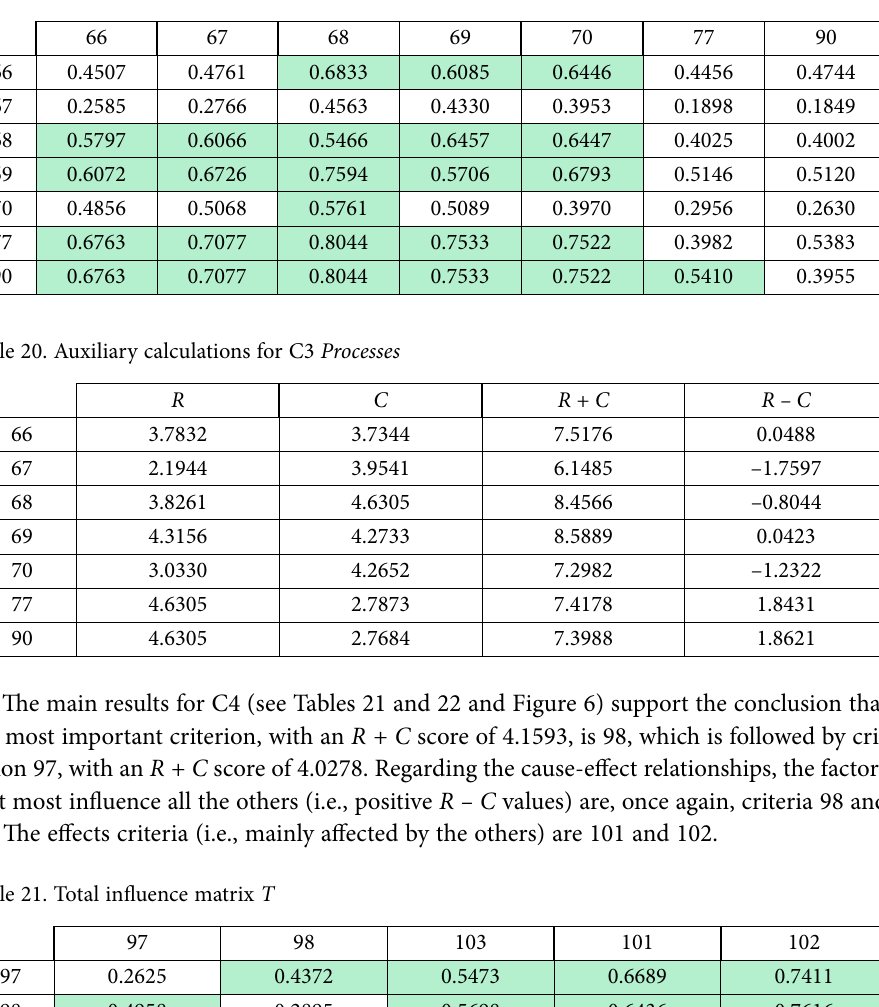
Table 19. Total influence matrix T